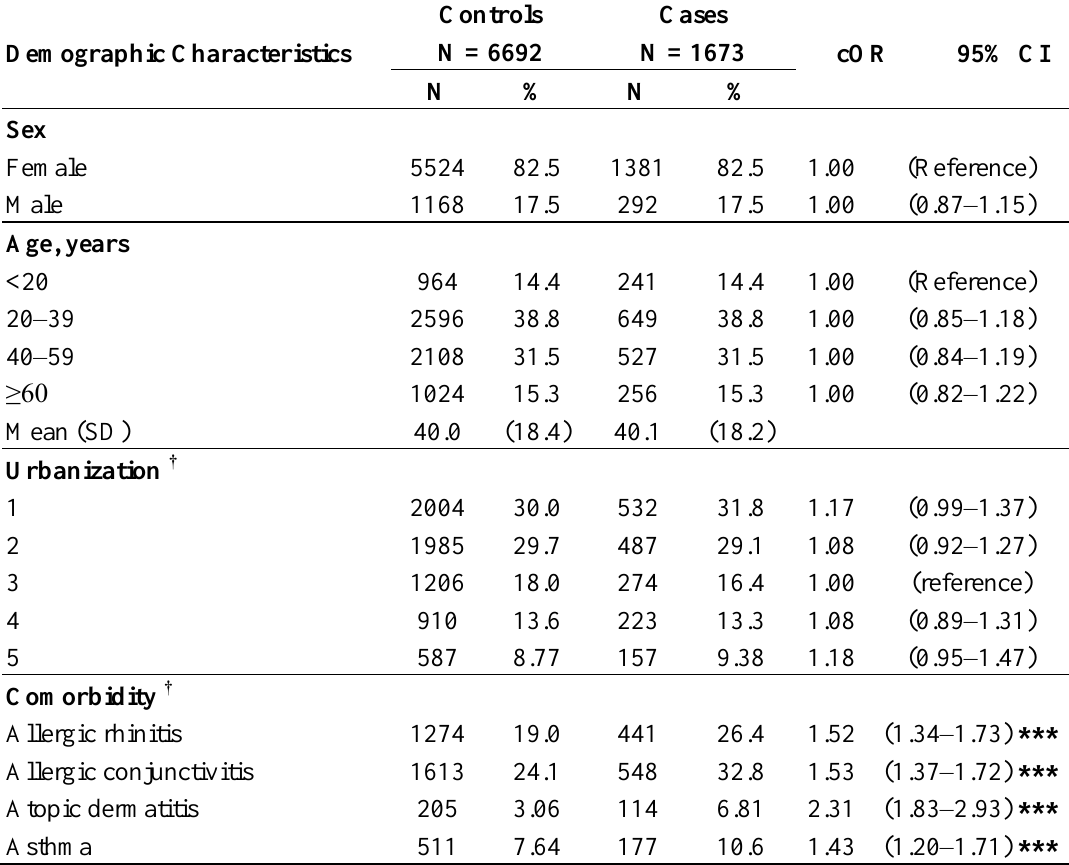
Table 1. Comparison in demographic characteristics and atopic diseases between SLE cases and controls.